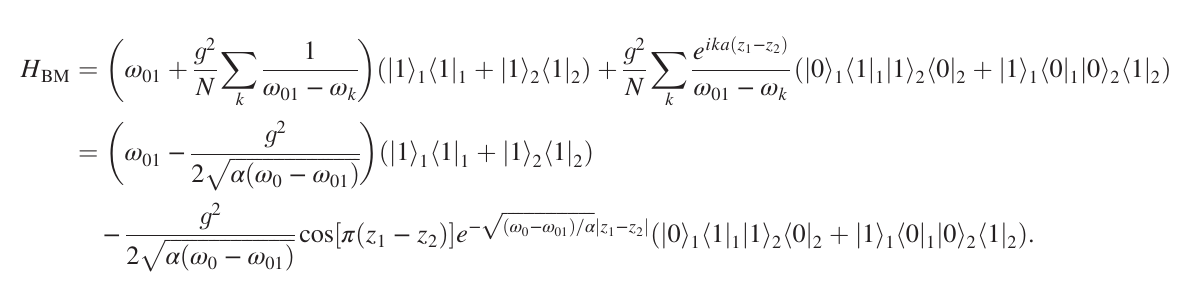
ffiffiffiffiffiffiffiffiffiffiffiffiffiffiffiffiffi